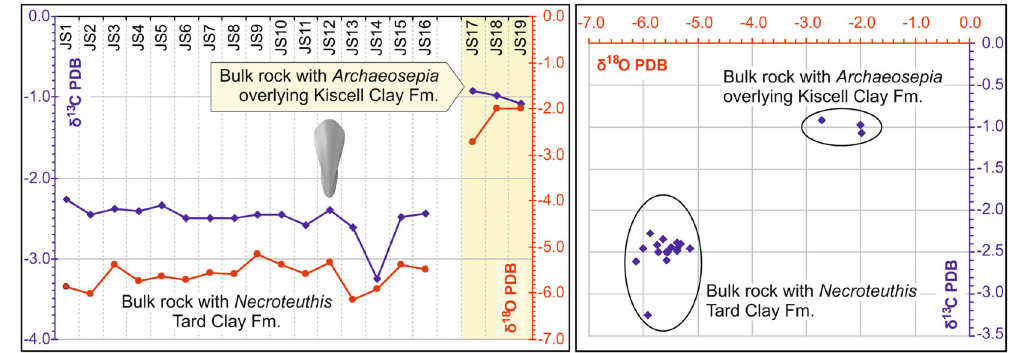
Fig. 7 Differences in the δ 13 C carb and δ 18 O carb isotopic signal from loligosepiid Necroteuthis -bearing sediment of the Tard Clay Fm. Samples (JS1 – JS16) and overlying, sepiid Archaeosepia -bearing sediment from the Kiscell Clay Fm. (samples JS17 – JS19). More positive values of δ 13 C carb and δ 18 O carb represent more oxygened normal marine environment in younger strata. An accurate level of of Necroteuthis gladius is indicated by picture